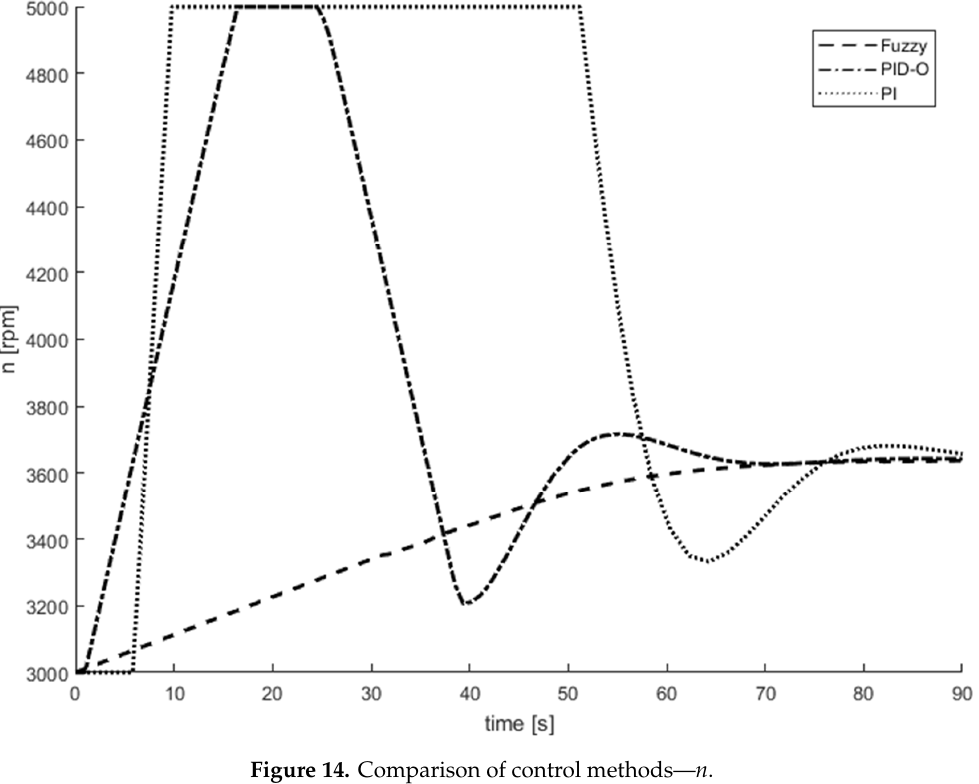
Figure 13. Comparison of control methods– Qair .